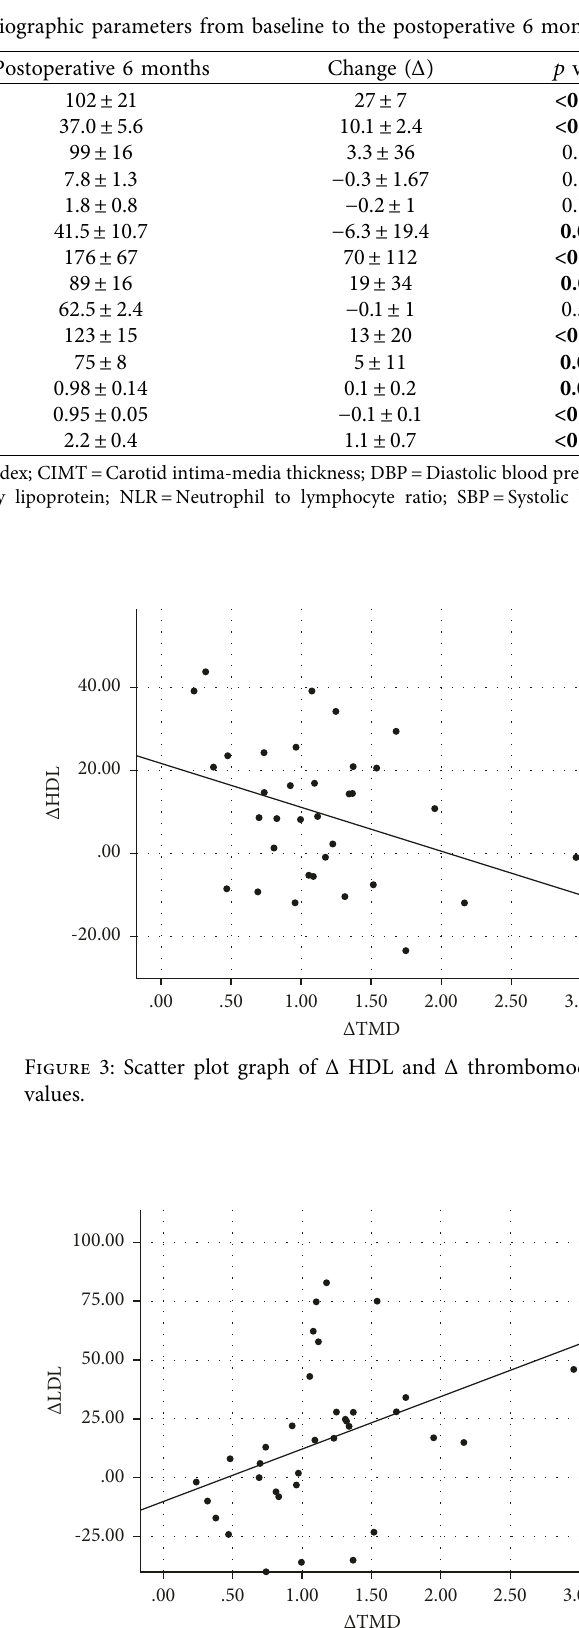
thrombomodulin Δ